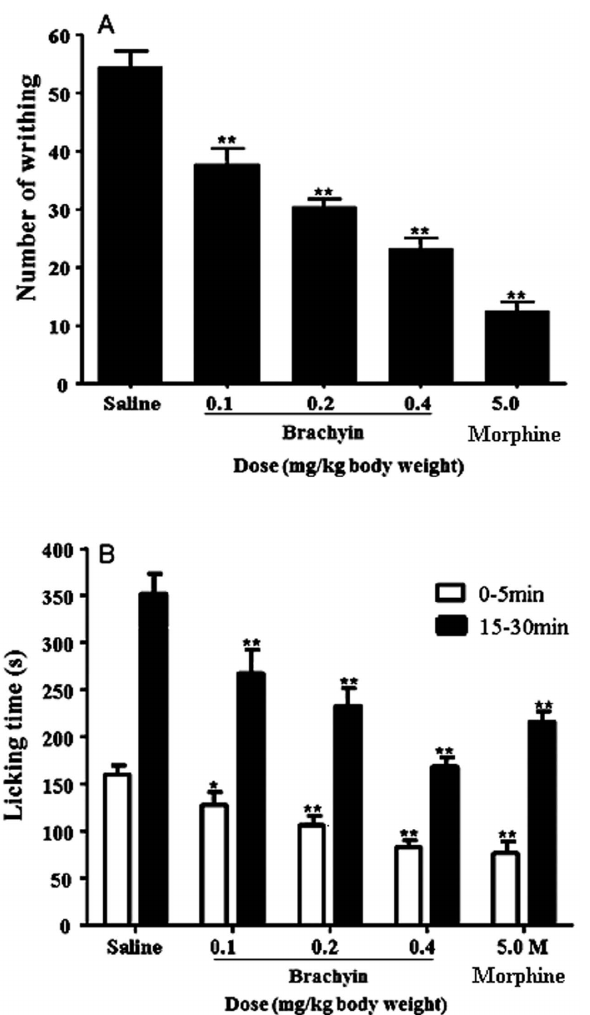
Figure 4. Analgesic activities of brachyin in the mice model of acetic acid-induced abdominal writhing (A) and formalin- induced paw licking (B). M: morphine. Data are means 6 SEM. Significant difference compared with control group treated by 0.9% saline is indicated by *( p , 0.05) or **( p , 0.01) (n=10).